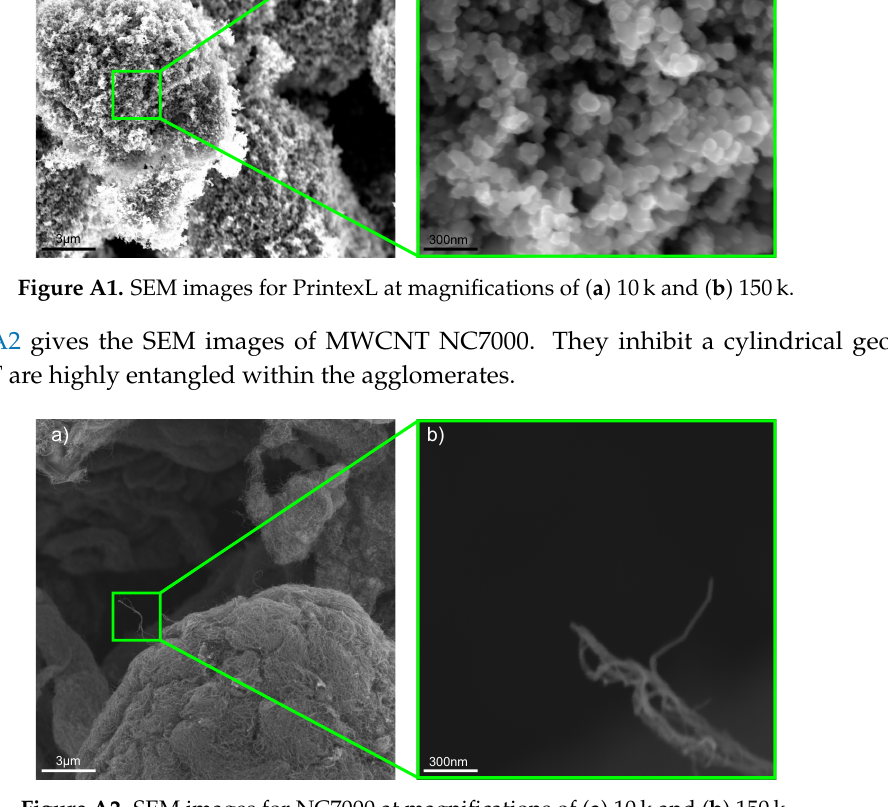
Figure A2. SEM images for NC7000 at magnifications of ( a ) 10k and ( b ) 150k.